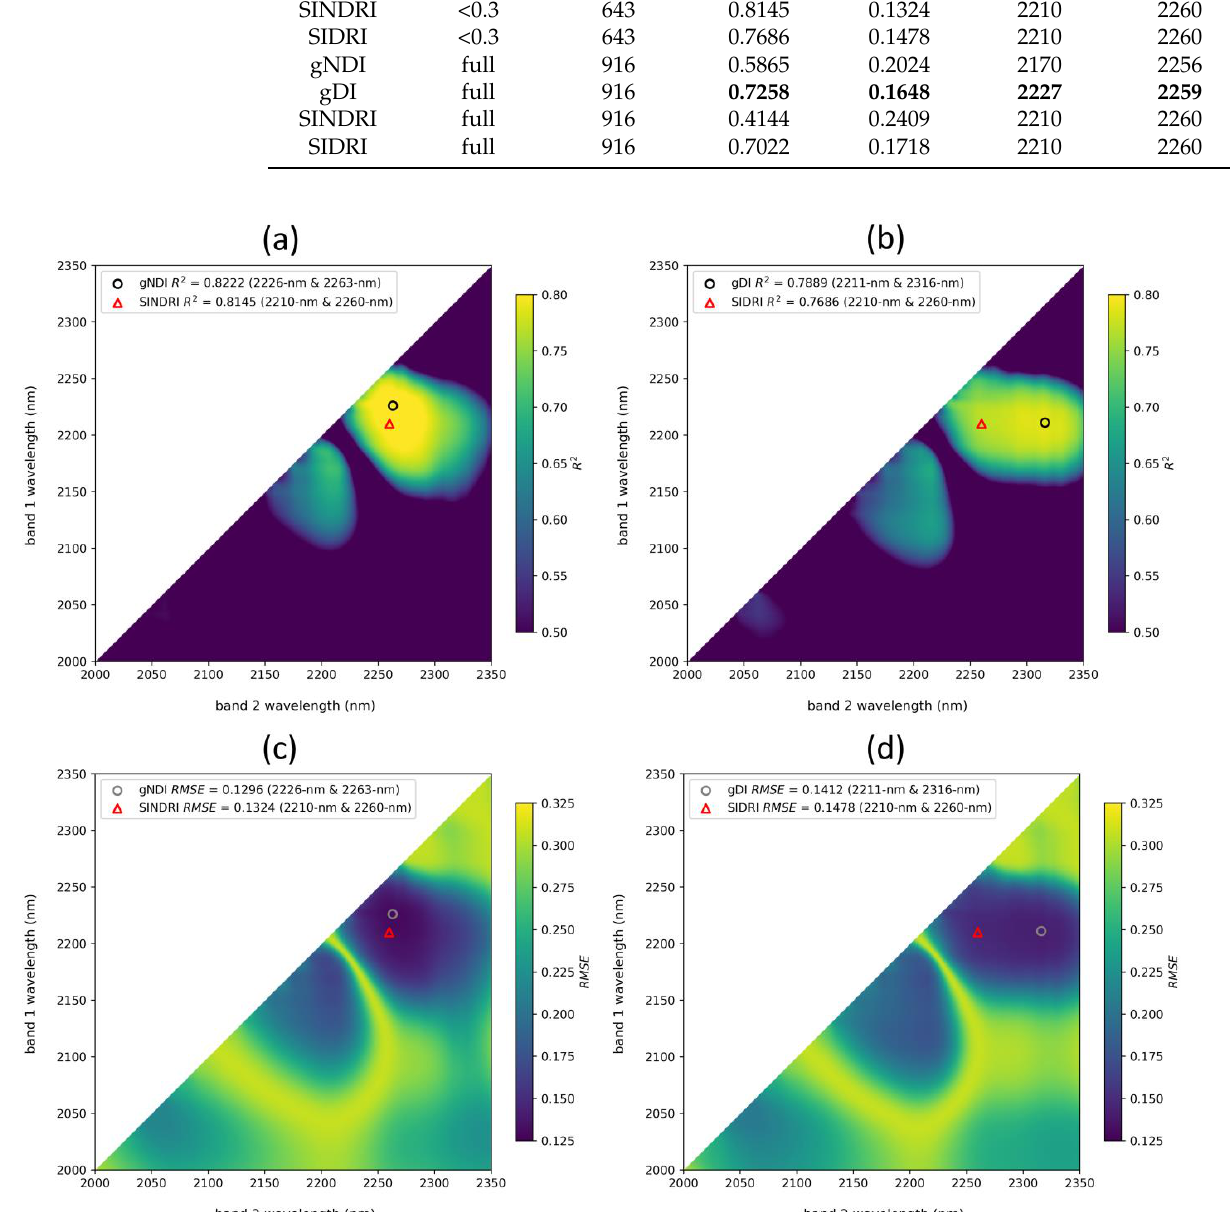
Figure 4. Performance metrics for two-band gNDI and gDI using 1 nm interval dataset with NDVI < 0.3 subset with n = 643: ( a ) gNDI- R 2 , ( b ) gDI- R 2 , ( c ) gNDI- RMSE , ( d ) gDI- RMSE . All spectra processed to surface reflectance. In all panels, the gray/black circles represent the band combination that produced the best f R estimation performance, as defined by the respective performance metric. The red triangles depict the band combination of a comparable heritage index.